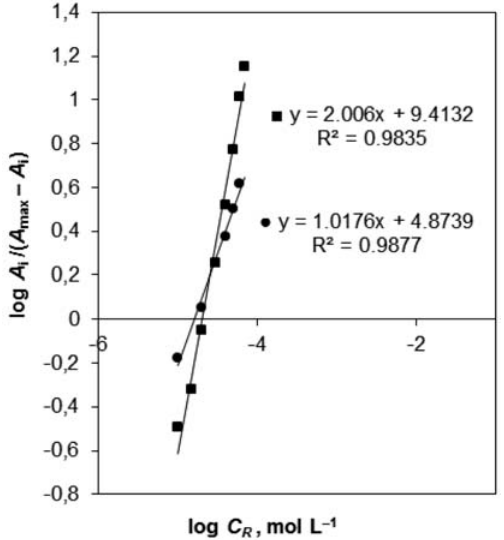
Figure 3. Straight lines by the mobile equilibrium method for de- termination of the molar ratios. Co : INT and Co : TAR ( C × 10 –5 mol L –1 ) • Co : INT, C C = 2.0 × 10 –4 mol L –1 INT